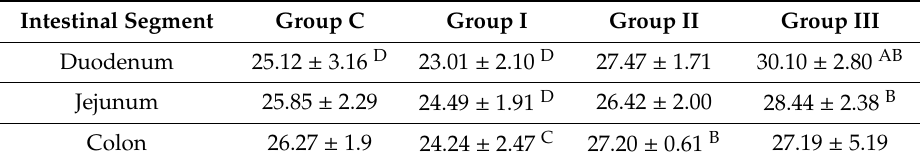
Table 1. Inflammatory bowel disease (IBD)-induced changes in the number of intramucosal vasoactive intestinal polypeptide (VIP)-like immunoreactive nerve fibers in one field of view in the duodenum, jejunum and descending colon of the control group (C) dogs and dogs with mild (Group I), moderate (Group II) and severe (Group III) IBD.